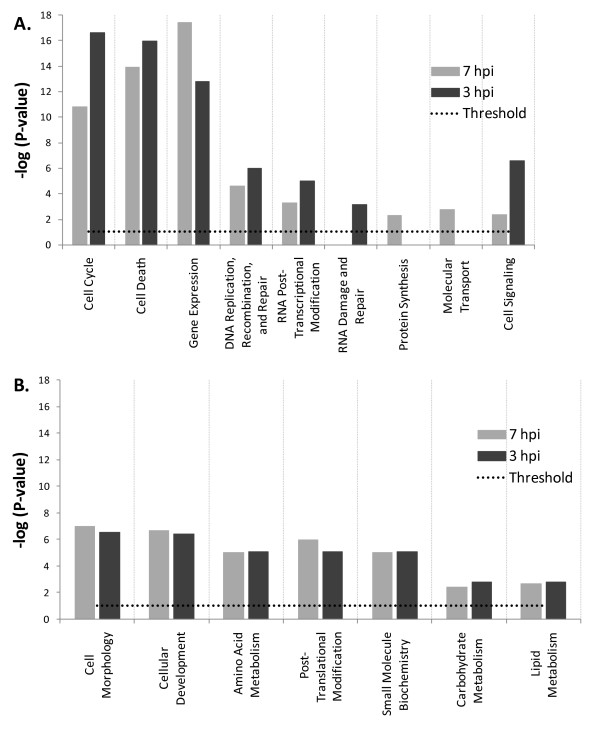
Comparative functional analysis of differentially expressed genes at 3 and 7 hpi. (A) Represents functions exhibiting -log (P-values) differences ≥ 1.301 between 3 and 7 hpi time points. Few identified functions were unique to one time point only under adopted statistical constraints. (B) Equally present functions in both time points showing a -log (P-value) differences ≤ 1.301. All functions were identified with P-values ≤ 0.05 or -log (P-value) = 1.301 thresholds (dotted black lines).